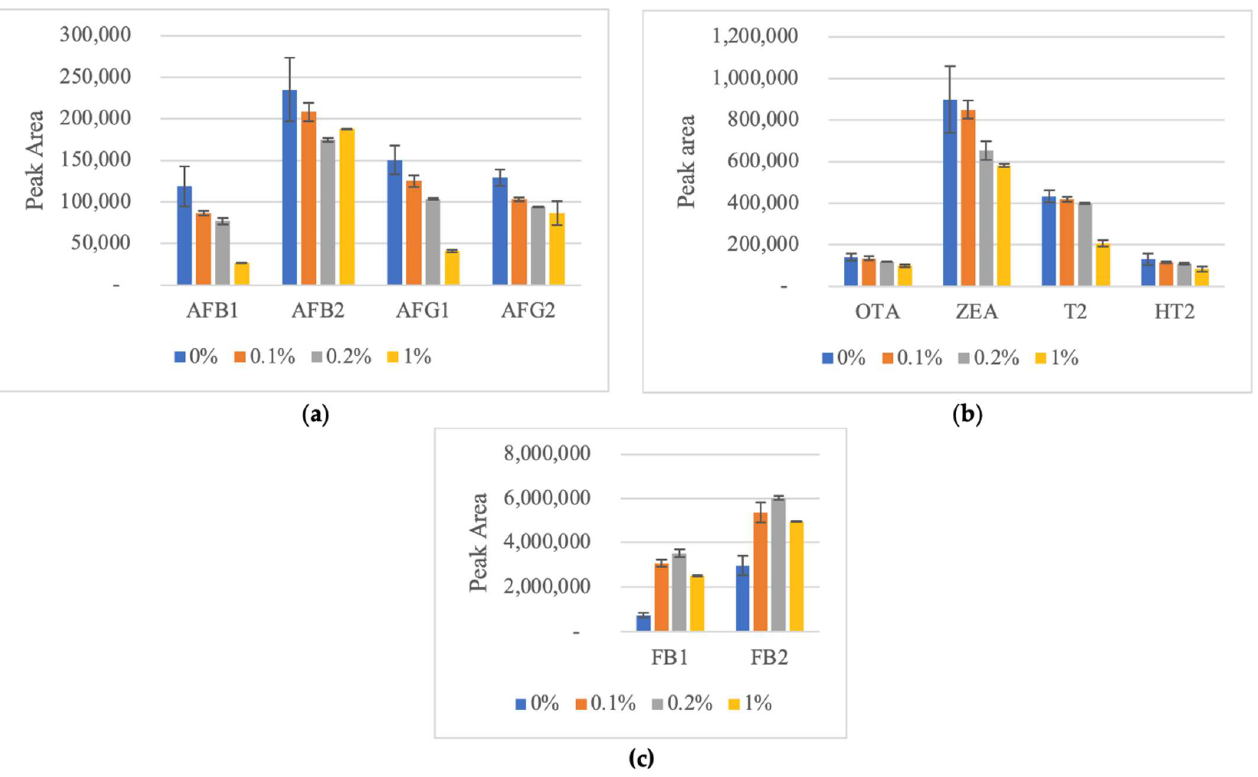
Figure 1. Effect of different levels of acidification of water with formic acid on the extraction of ( a ) AFs (AFB1–Aflatoxin B1; AFB2–Aflatoxin B2; AFG1–Aflatoxin G1; AFG2–Aflatoxin G2) and ( b ) Ochratoxin A (OTA), Zearalenone (ZEA), toxin T2 (T2) and toxin HT-2 (HT2) and ( c ) FBs (Fumonisins, FB1, and FB2) on average peak areas (n = 2).